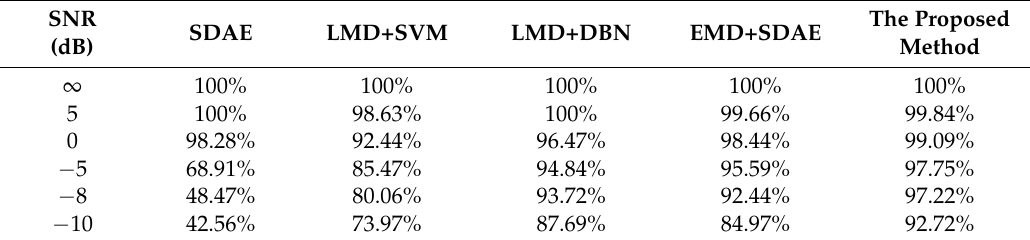
Table 4. Classification accuracy results by different methods.